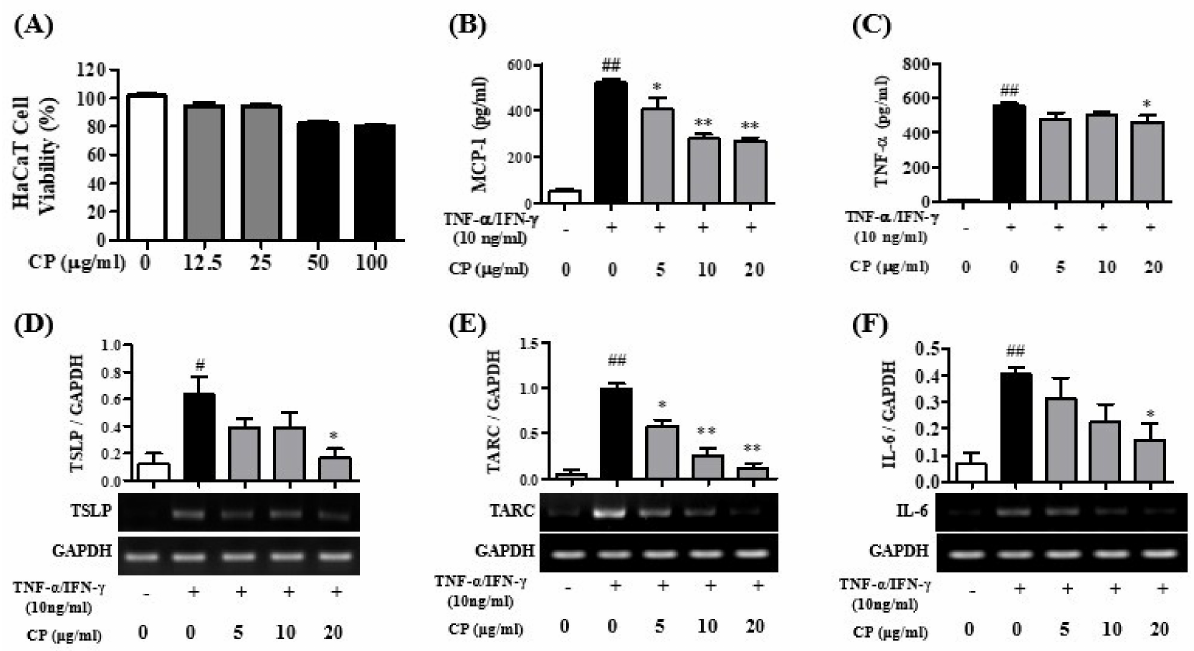
Figure 2. Effect of Cone of Pinus densiflora (CP) on TNF- α /IFN- γ -stimulated HaCaT cells. ( A ) Viability of CP in HaCaT cell by MTS assay. HaCaT cells were treated with different concentrations of CP (0, 12.5, 25, 50 and 100 µ g/mL) for 24 h. ( B , C ) MCP-1, TNF- α expression in TNF- α /IFN- γ -stimulated HaCaT cells. The cells were treated with different concentrations of CP (5, 10 and 20 µ g/mL) for 1 h and then treated with TNF- α /IFN- γ (10 ng/mL) for 24 h. Absorbance was measured using a microplate reader at 490 nm. ( D – F ) mRNA levels of inflammatory cytokine in TNF- α /IFN- γ -stimulated HaCaT cells. The cells were treated with different concentrations of CP (5, 10 and 20 µ g/mL) for 1 h and then treated with TNF- α /IFN- γ (10 ng/mL) for 3 h (TSLP) of 24 h (TARC and IL-6). The mRNA expression level of TSLP, TARC and IL-6 was quantitative, analyzed by comparing it with GAPDH in the Image J Program. All data represent the means ± SEM ( # p < 0.05 and ## p < 0.01 vs. TNF- α /IFN- γ non-treat group. * p < 0.05 and ** p < 0.01 vs. only TNF- α /IFN- γ -treat